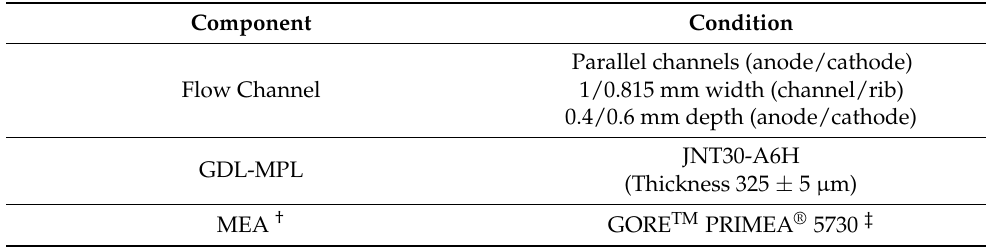
Table 2. Specifications of the unit